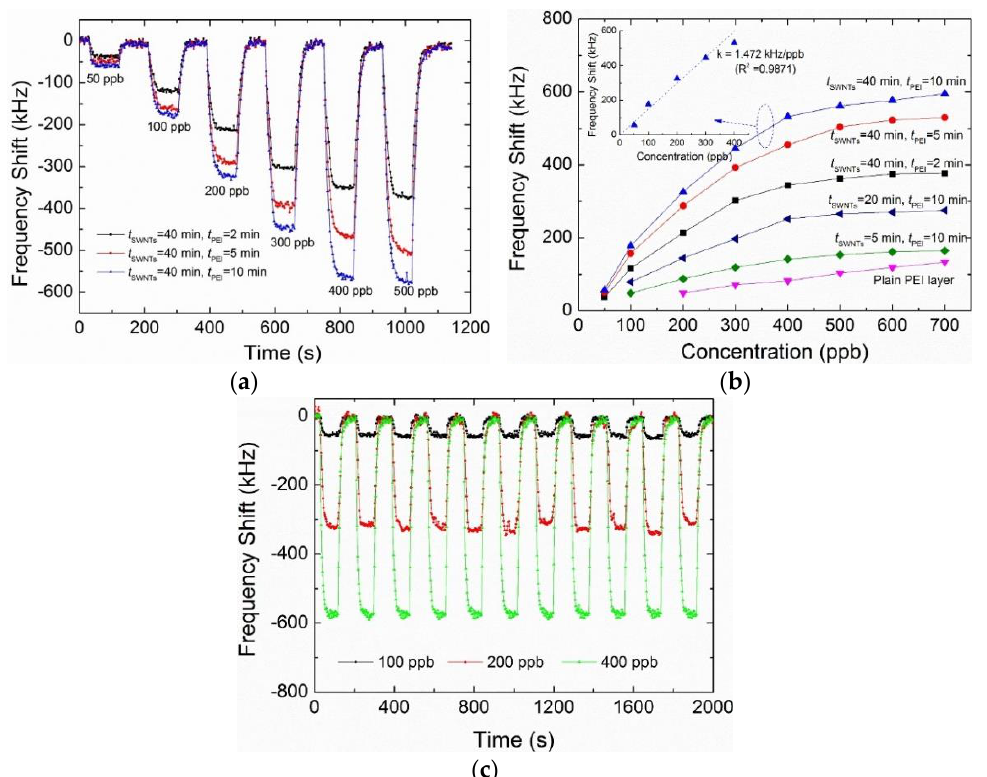
Figure 15. ( a ) Dynamic measurement of FBAR sensors in various sensitive layers exposed to formaldehyde pulse at 23 °C and 40% RH with increasing concentration; ( b ) frequency shift of the FBAR sensors with various sensitive layers as a function of formaldehyde at 23 °C and 40% RH. The inset shows the typical linear fitting of the measured results; ( c ) real-time response towards the sequential pulses of three typical formaldehyde concentrations [86].